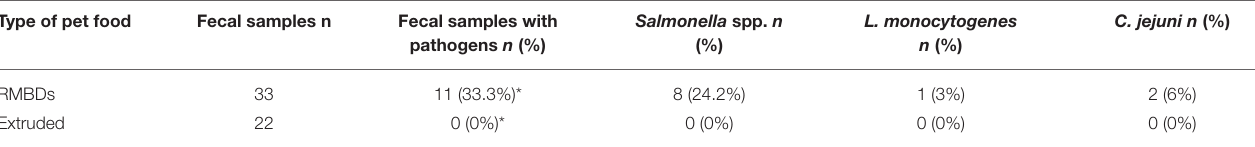
TABLE 1 | Total fecal samples analyzed ( n = 55) and number of positive samples for Salmonella spp., L. monocytogenes, and C. jejuni according to the type of pet food. Salmonella spp. n L. monocytogenes C. jejuni n (%) Type of pet food Fecal samples n Fecal samples with n (%) pathogens n (%) (%) RMBDs 33 11 (33.3%)* 8 (24.2%) 1 (3%) 2 (6%) Extruded 22 0 (0%)* 0 (0%) 0 (0%) 0